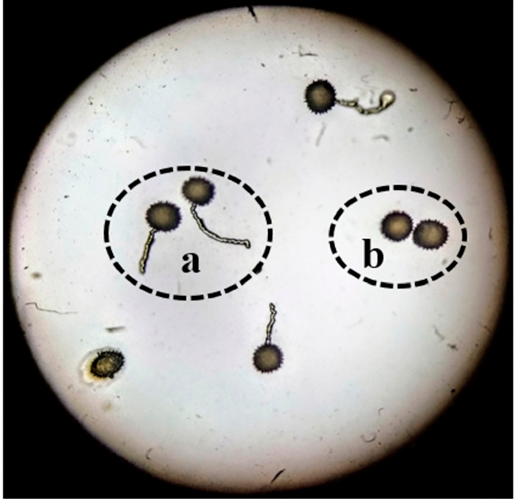
Figure 1. An example of pollen tube growth. A pollen grain that has germinated its pollen tube is labeled as ‘a’ while non-germinating pollen grains are labeled as ‘b’. The triphenyl-tetrazolium chloride (TTC) test was used to test the viability of pollen grains [26]. Flowers that showed dehiscence of anthers were taken into the laboratory to test pollen viability. Fresh pollen grains were sprinkled on a glass slide (76 × 26 mm) by gently tapping the flower. Two to three drops of 0.5% 2,3,5-triphenyl tetrazolium chloride (Product no. 17779, Millipore, Merck, Germany) were added in a 15% sucrose solution (Product no. S0389, Sigma Aldrich, Merck, Germany). The slide was covered with a co- verslip (20 × 20 mm) to prevent desiccation and then placed under sunlight for 60 min at